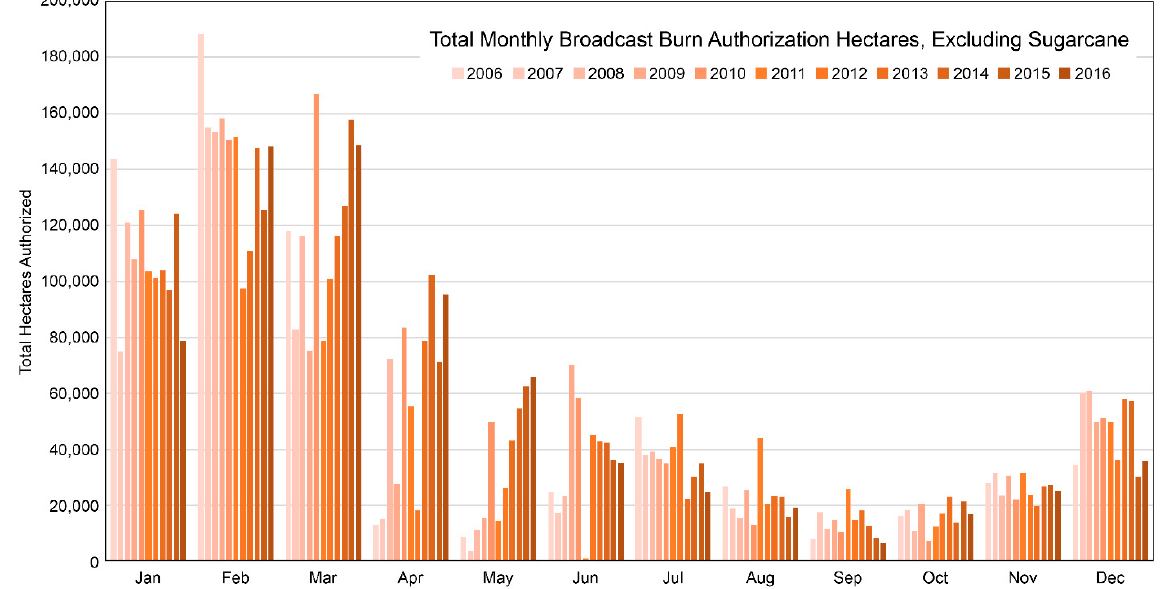
Figure 2. Monthly burning trends in area for broadcast burn authorizations in Florida for the period 2006–2016, derived from the Open Burn Authorization (OBA) dataset.